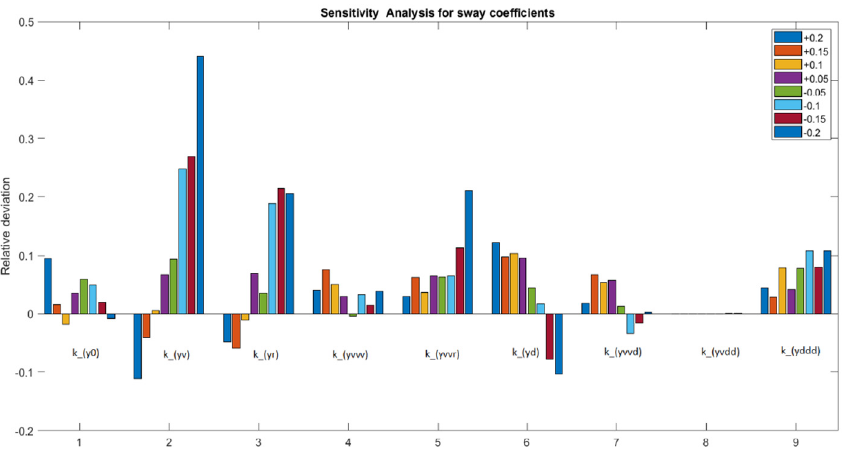
Figure 16. Sensitivity analysis for sway coefficients.